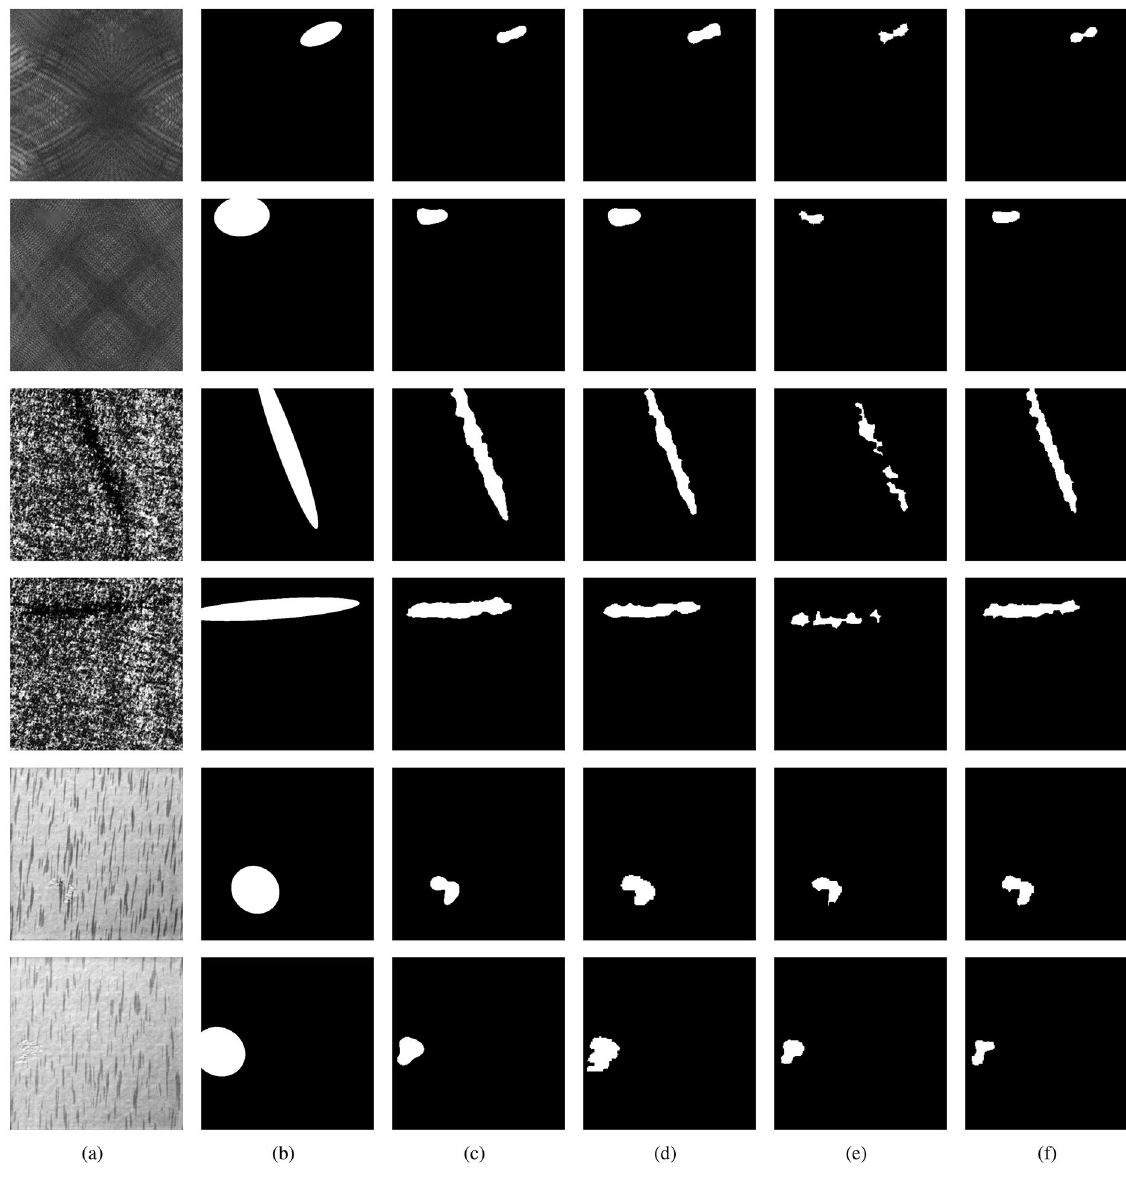
Figure 5. Comparison of defect extraction results. ( a ) Original image, ( b ) label, ( c ) UNet, ( d ) ResUNet++, ( e ) DCGAN, ( f ) ISU-GAN.